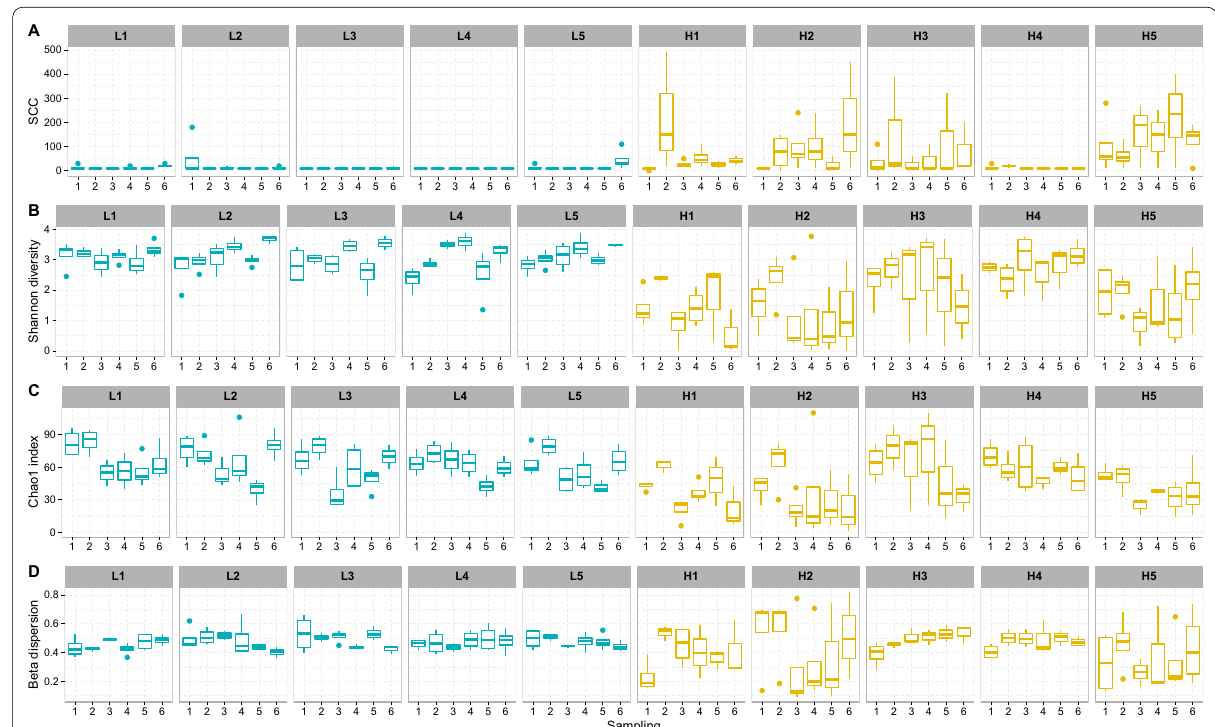
Fig. 1 ( A ) SCC, ( B ) Shannon diversity, ( C ) Chao1 index, and ( D ) Multivariate homogeneity of group dispersions. A , B , C , and D are plotted per individual cow (blue represents L-cows, yellow represents H-cows) and shown for all six